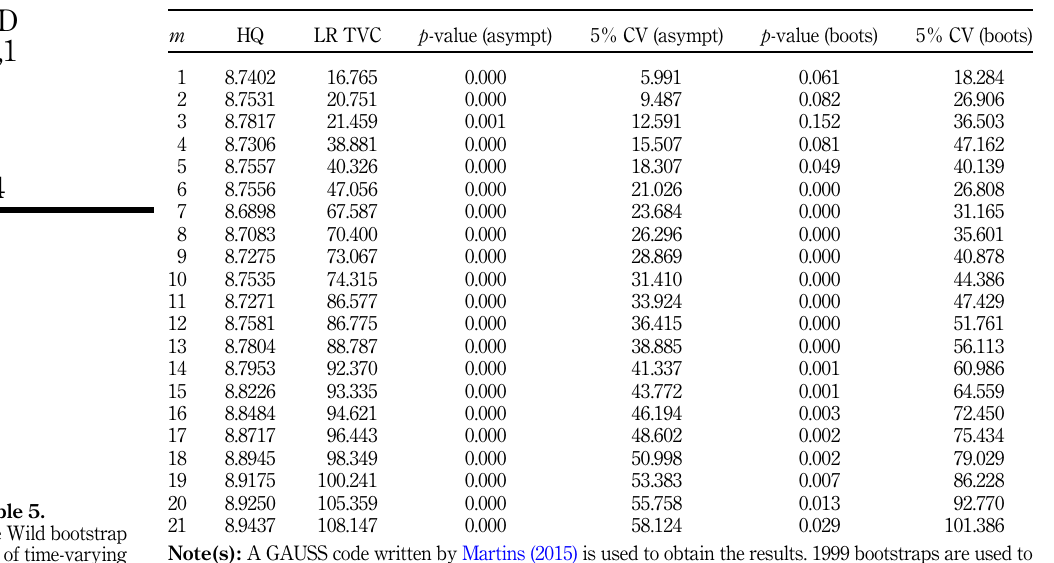
Table 5. The Wild bootstrap test of time-varying